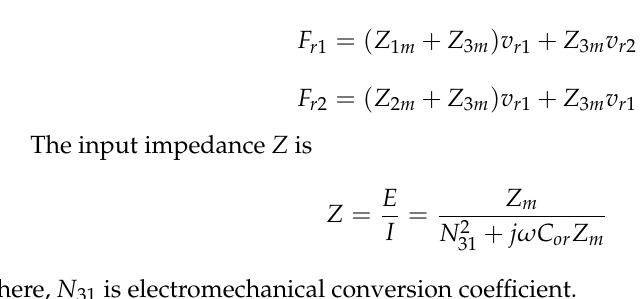
Figure 10. Schematic diagram of piezoelectric ring with metal ring ( left ) and its electromechanical equivalent circuit ( right ).